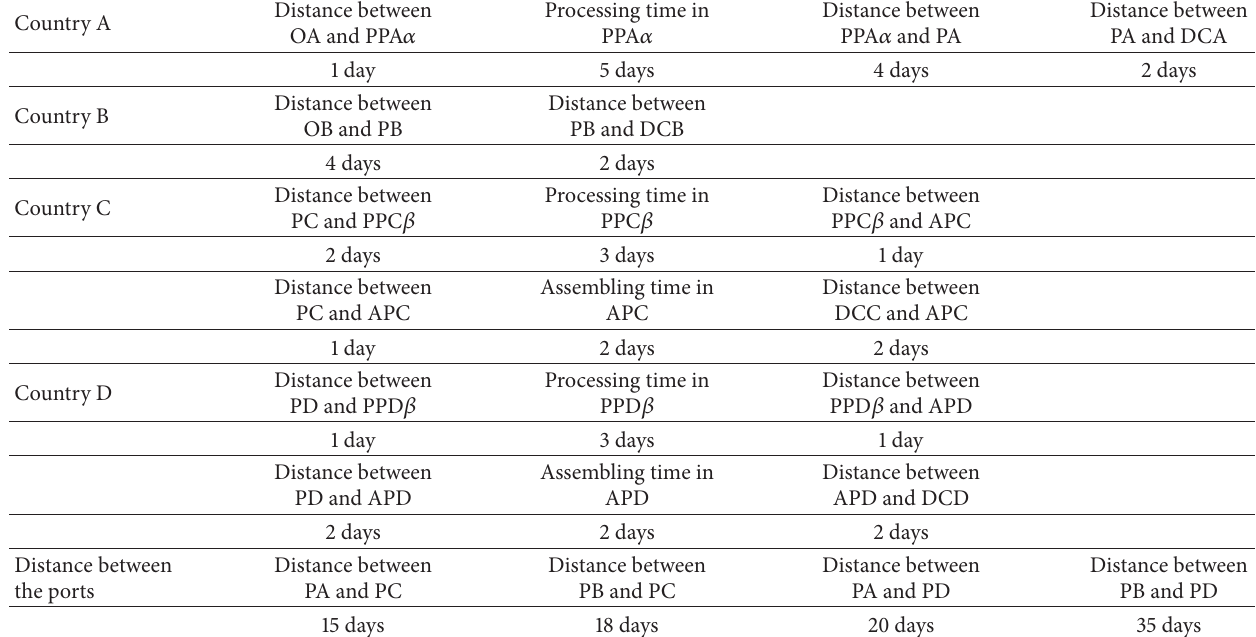
Table 9: Setting of parameters in Scheme 3.